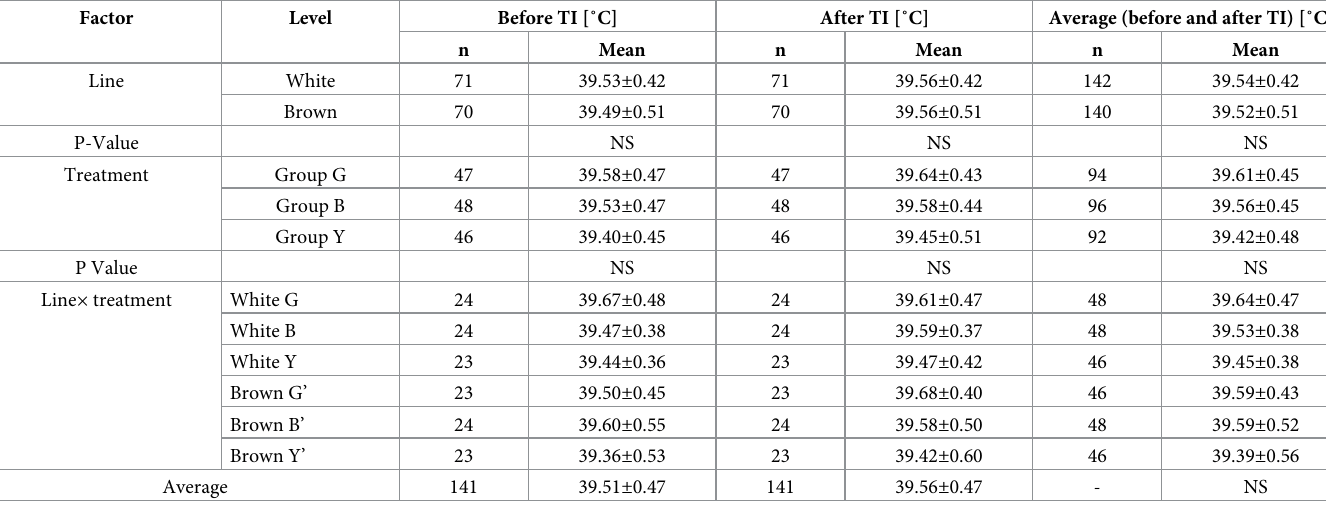
exposed to other non-handling stressors, such as heat stress [41] and dietary mycotoxin [42]. Stress upregulates the HPA axis, leading to the release of corticotropin releasing factor and cortisol [43–45], and has a direct effect on the gastrointestinal tract to increase intestinal per- meability, known as “leaky gut” [46]. Probiotics, as beneficial bacteria, have been used as thera- peutics for stress related inflammatory bowel disease [47,48] and mental disorders in humans [49]. The underlying cellular mechanisms of probiotic functions are able to inhibit binding of